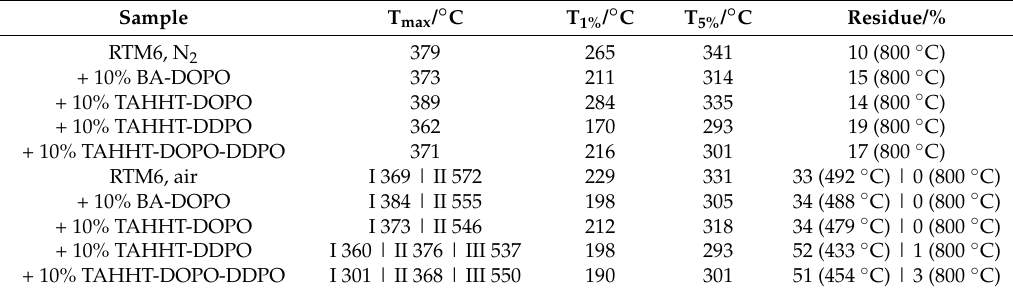
Figure 5. TG-curves of RTM6 and flame-retarded samples measured under air. Table 5. T max , T 1% , T 5% and residue of formulations of RTM6 and phosphorus containing flame retardants obtained by TG measurements under air or nitrogen atmosphere with a heating rate of 10 K · min − 1